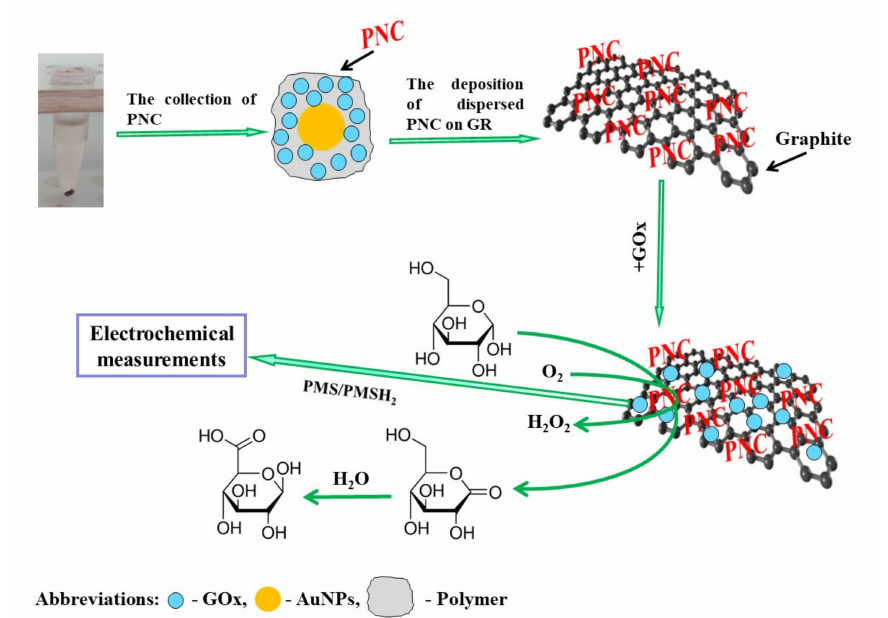
Figure 1. Schematic representation of the deposition of PANI-AuNPs (6 nm) -GOx or Ppy-AuNPs (6 nm) - GOx nanocomposites (PNC) on the surface of GR electrode with the following additional enrichment by GOx, and glucose determination by the developed enzymatic